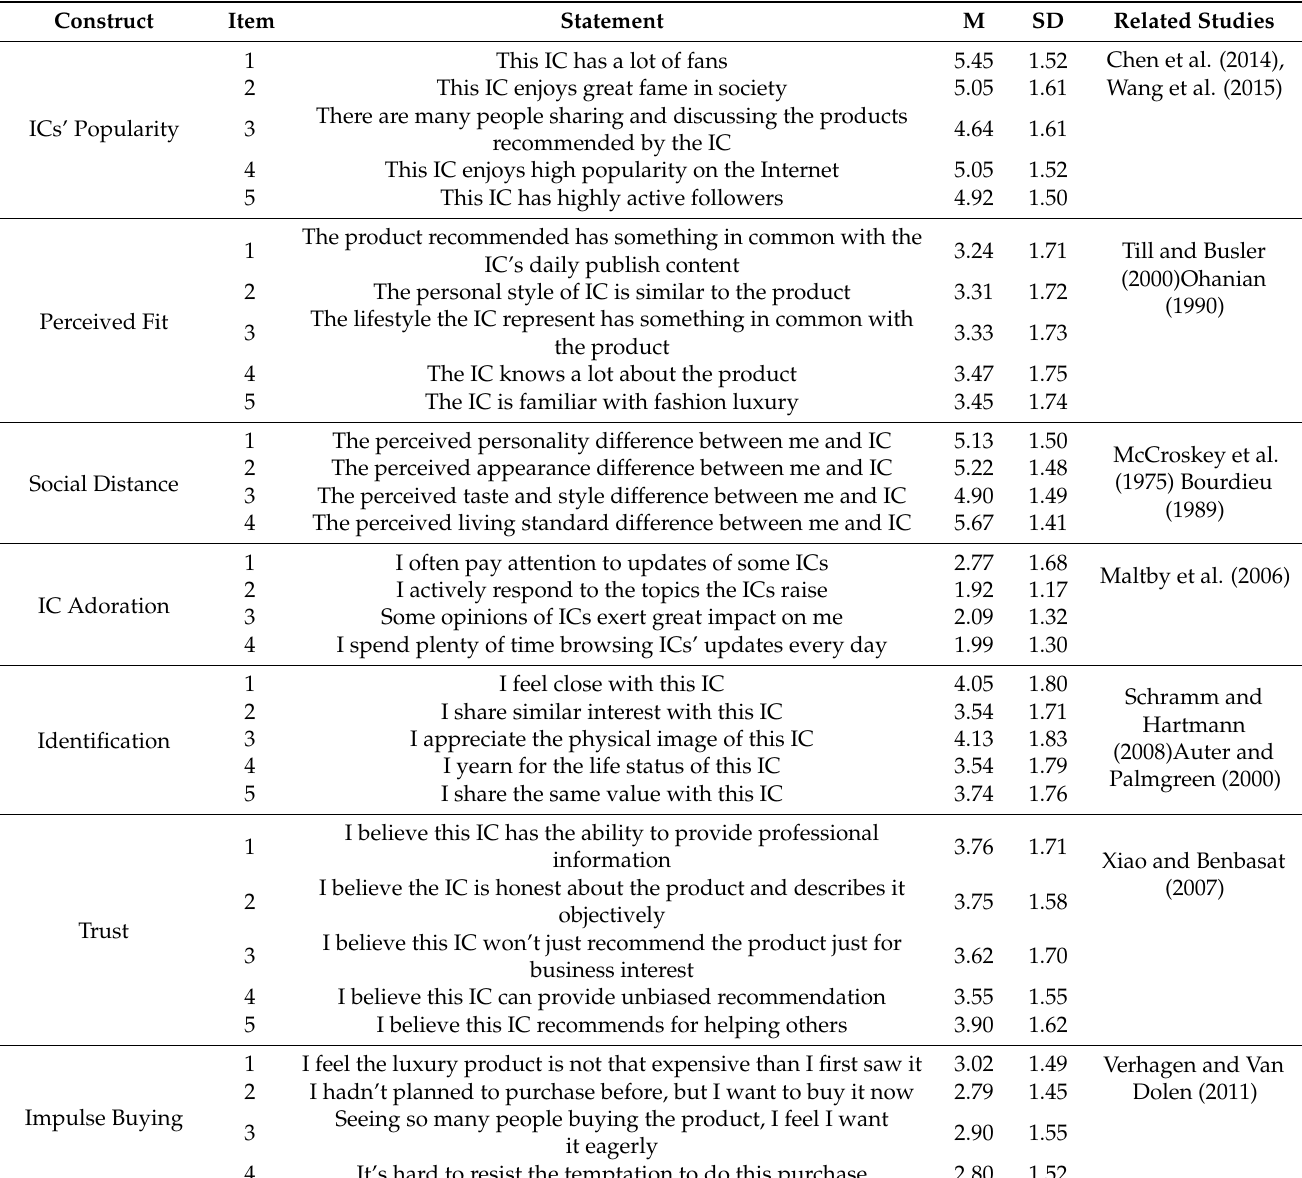
Table 1. Descriptive statistics of key variable